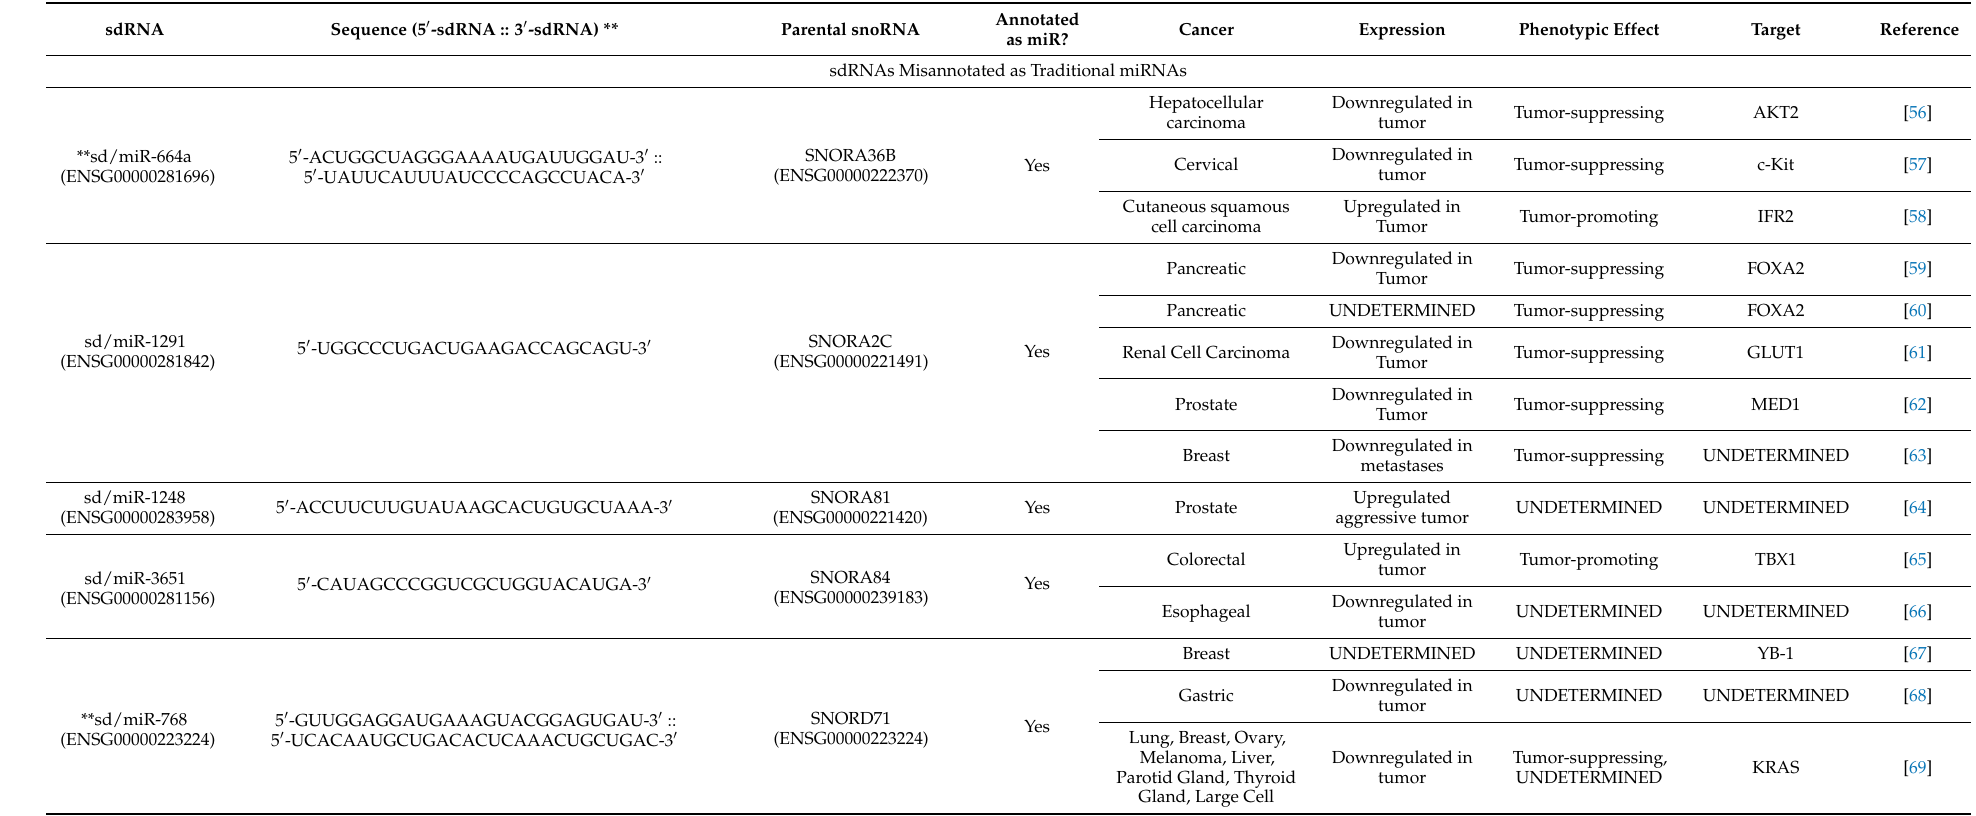
Table 1. Summary of sdRNAs implicated in